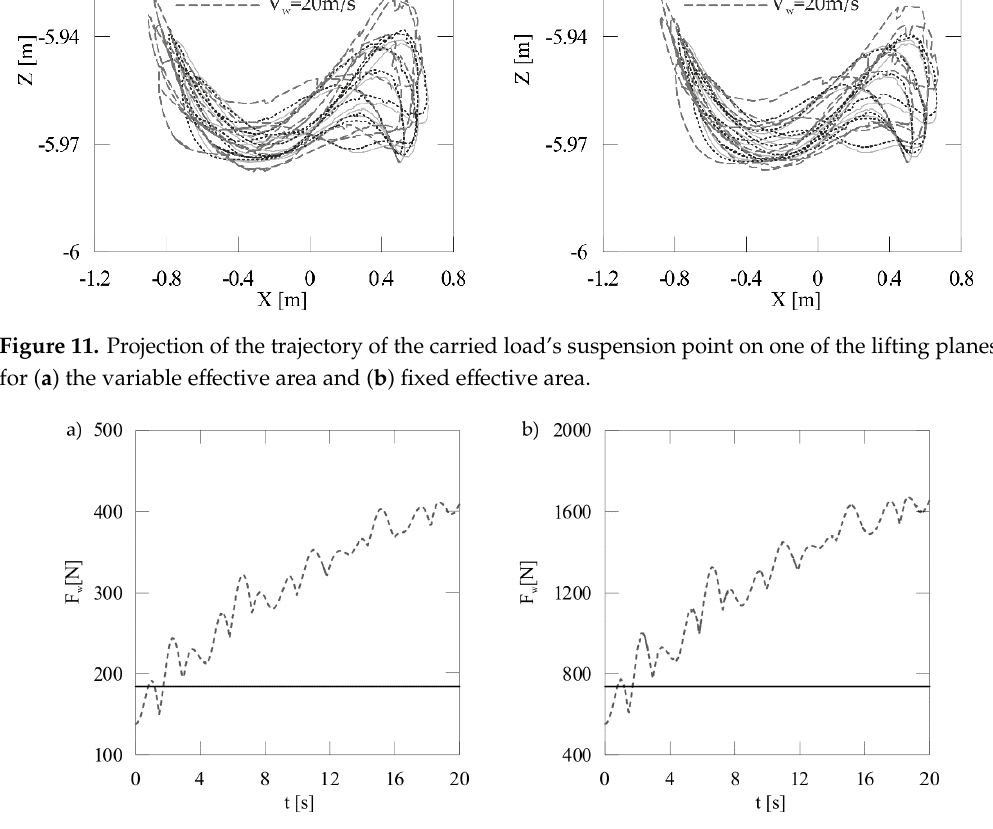
Figure 12. Value of the wind impact force with respect to wind velocity equal to ( a ) 10 m/s and ( b ) 20 m/s (continuous line—fixed area, dotted line—variable area).